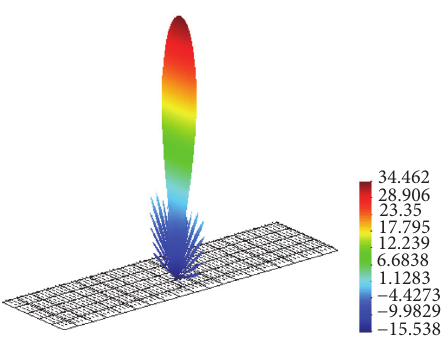
Figure 16: 3D gain patterns of the wire array.